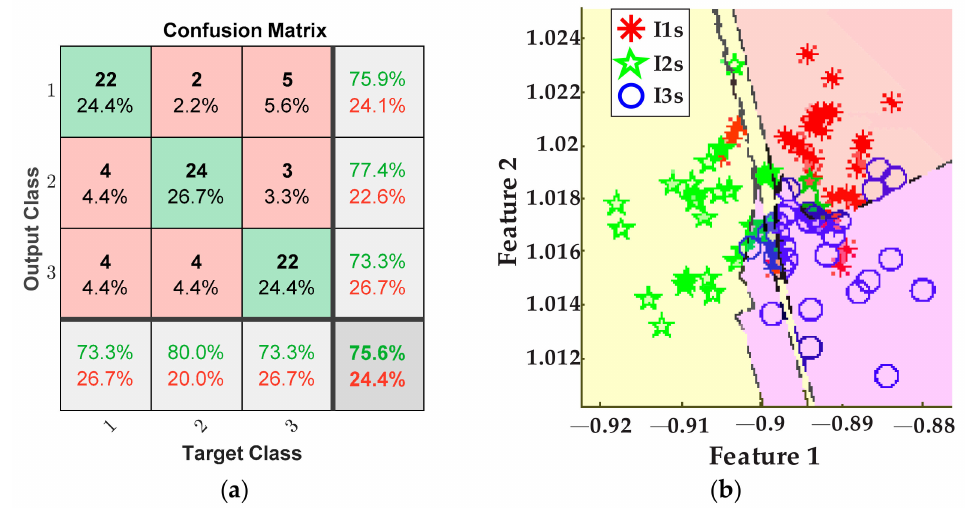
Figure 13. Results from cutting speed variations for the stray flux sensors; ( a ) confusion matrix and ( b ) ANN